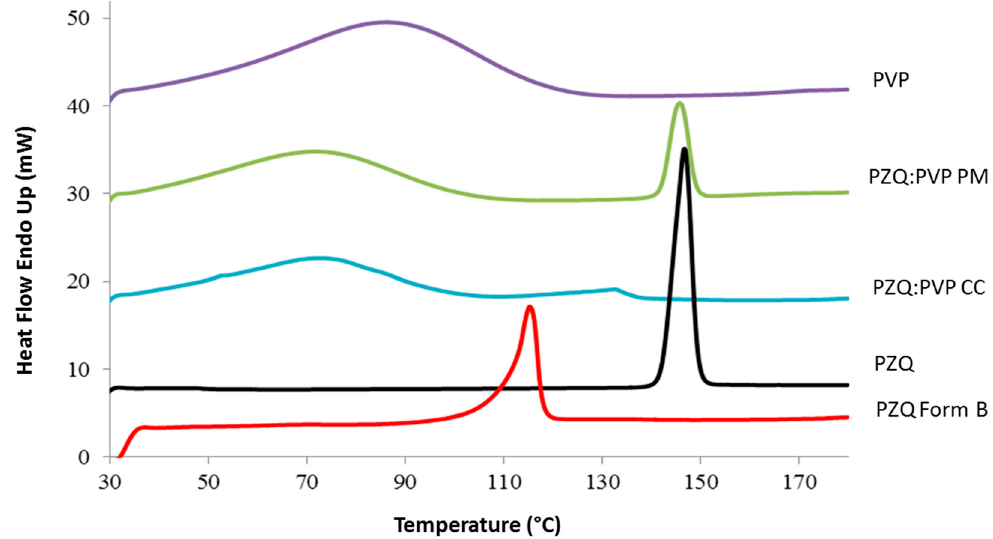
Figure 2. Differential Scanning Calorimetry (DSC) curve overlay of raw PZQ, PVP K30, PZQ:PVP PM, and activated materials (PZQ:PVP CC and PZQ Form B).